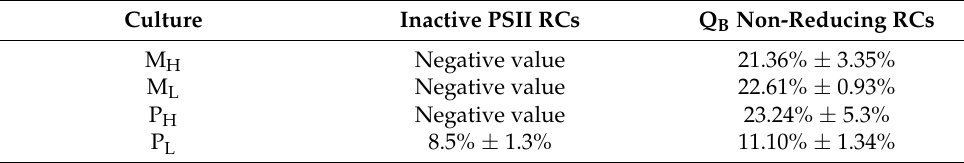
Table 3. Inactive PSII RCs and Q B Non-Reducing RCs of A. protothecoides cultivated under white light. (M H and M L stands for mixotrophy with high and low peptone, respectively, and P H and P L stands for photoautotrophy with high and low peptone,